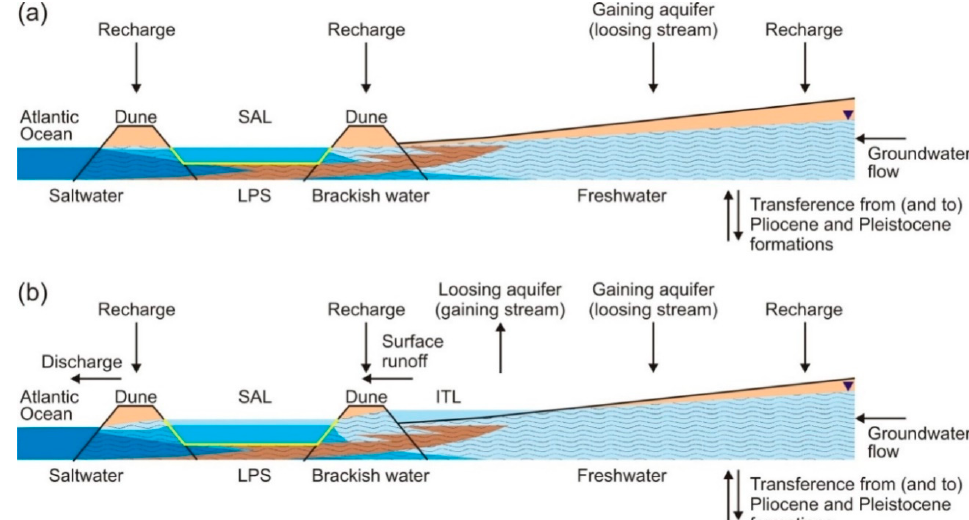
Figure 2. Conceptualization of the hydrogeological functioning of aquifer H during ( a ) the dry phase in summer and ( b ) predominant rainy phase in winter. Scale-out scheme after [7,46,51], and direct field observations. SAL, Santo André lagoon; LPS, low-permeability (clay-rich) lagoon sediments; ITL, inland temporary lagoon.